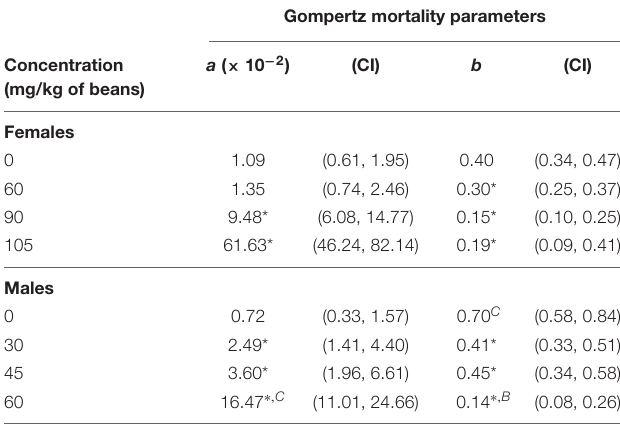
TABLE 2 | Gompertz mortality parameters ( a – initial mortality; b – exponential increase in mortality with age) and 95% confidence intervals (CI) in Acanthoscelides obtectus females and males exposed to different thymol